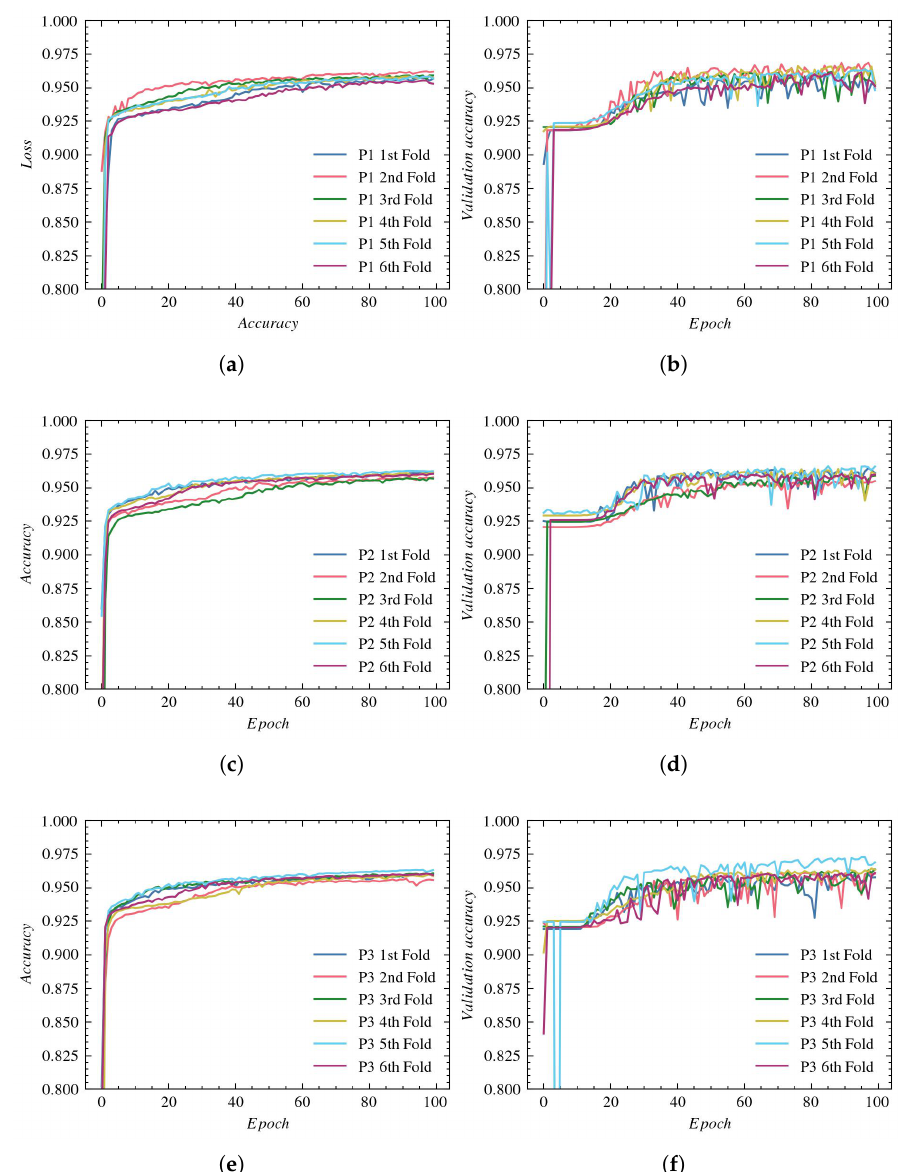
Figure 12. Accuracy plots for SA-UNet architecture: ( a ) training using P1, ( b ) validation using P1, ( c ) training using P2, ( d ) validation using P2, ( e ) training using P3, ( f ) validation using